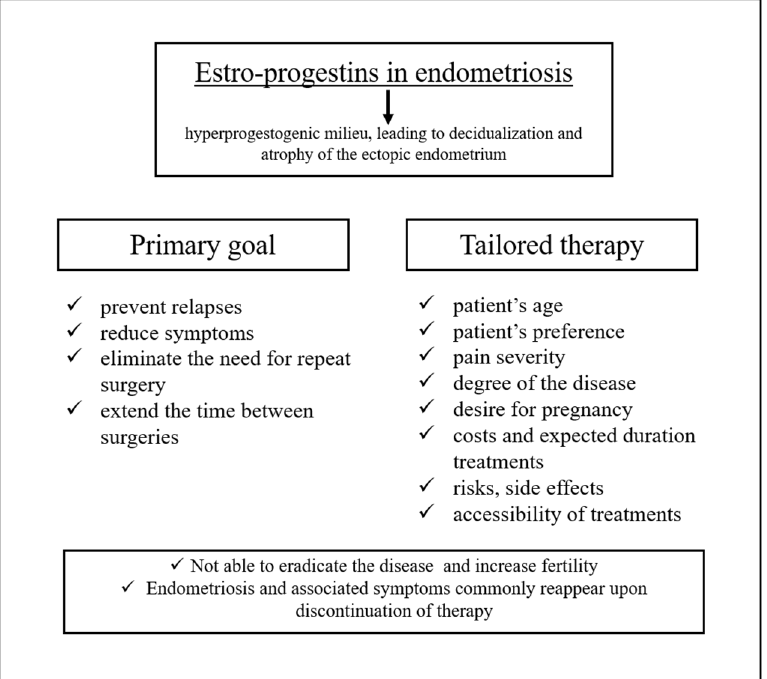
Figure 1. Overview of medical management of endometriosis with estro-progestins. COCs con- tain estrogen plus progestin capable of causing central inhibition of gonadotropin release, inhibiting ovulation and overall decreasing serum estrogen levels. They can determine a hyperprogestogenic milieu. The primary goal of medical management is to prevent relapses and reduce symptoms, thereby eliminating the need for repeat surgery or extending the time between surgeries. Therefore, all hormonal treatments should be considered suppressive rather than curative. The choice of med- ication depends on several factors including patient’s age and preferences, pain severity and degree of the disease, and the desire for pregnancy. Additional factors to consider are the costs and ex- pected duration, as well as risks, side effects, and accessibility of treatments.